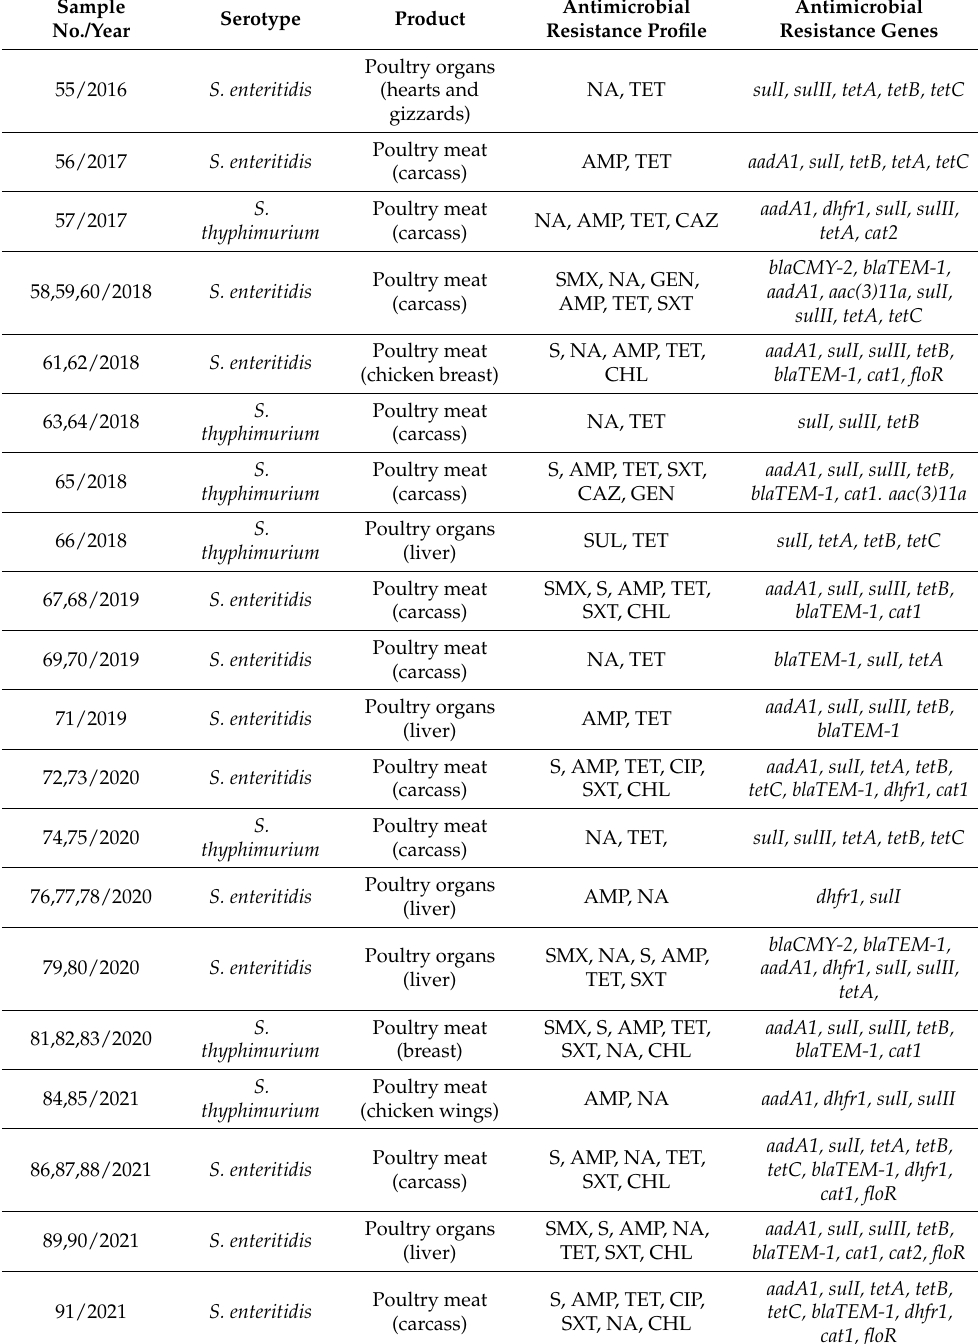
Table 2. Antimicrobial susceptibility of Salmonella isolates in poultry meat and poultry meat products in the period